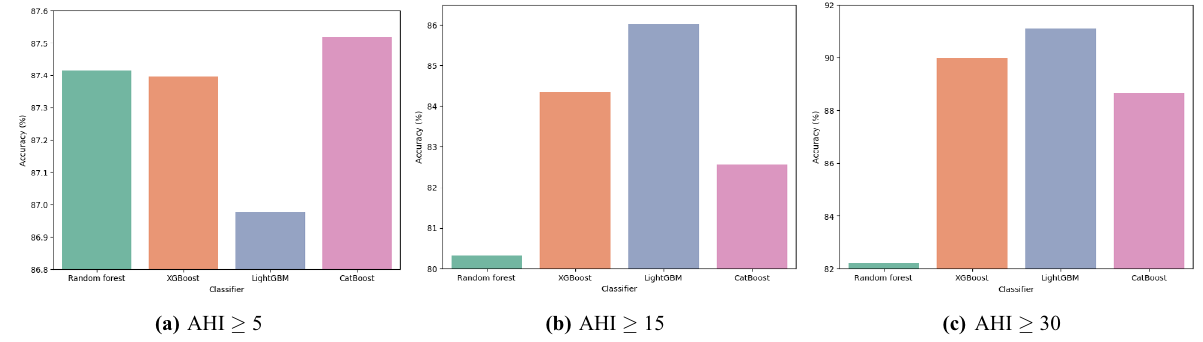
Figure 4. Comparisons of classification accuracy by machine learning classification